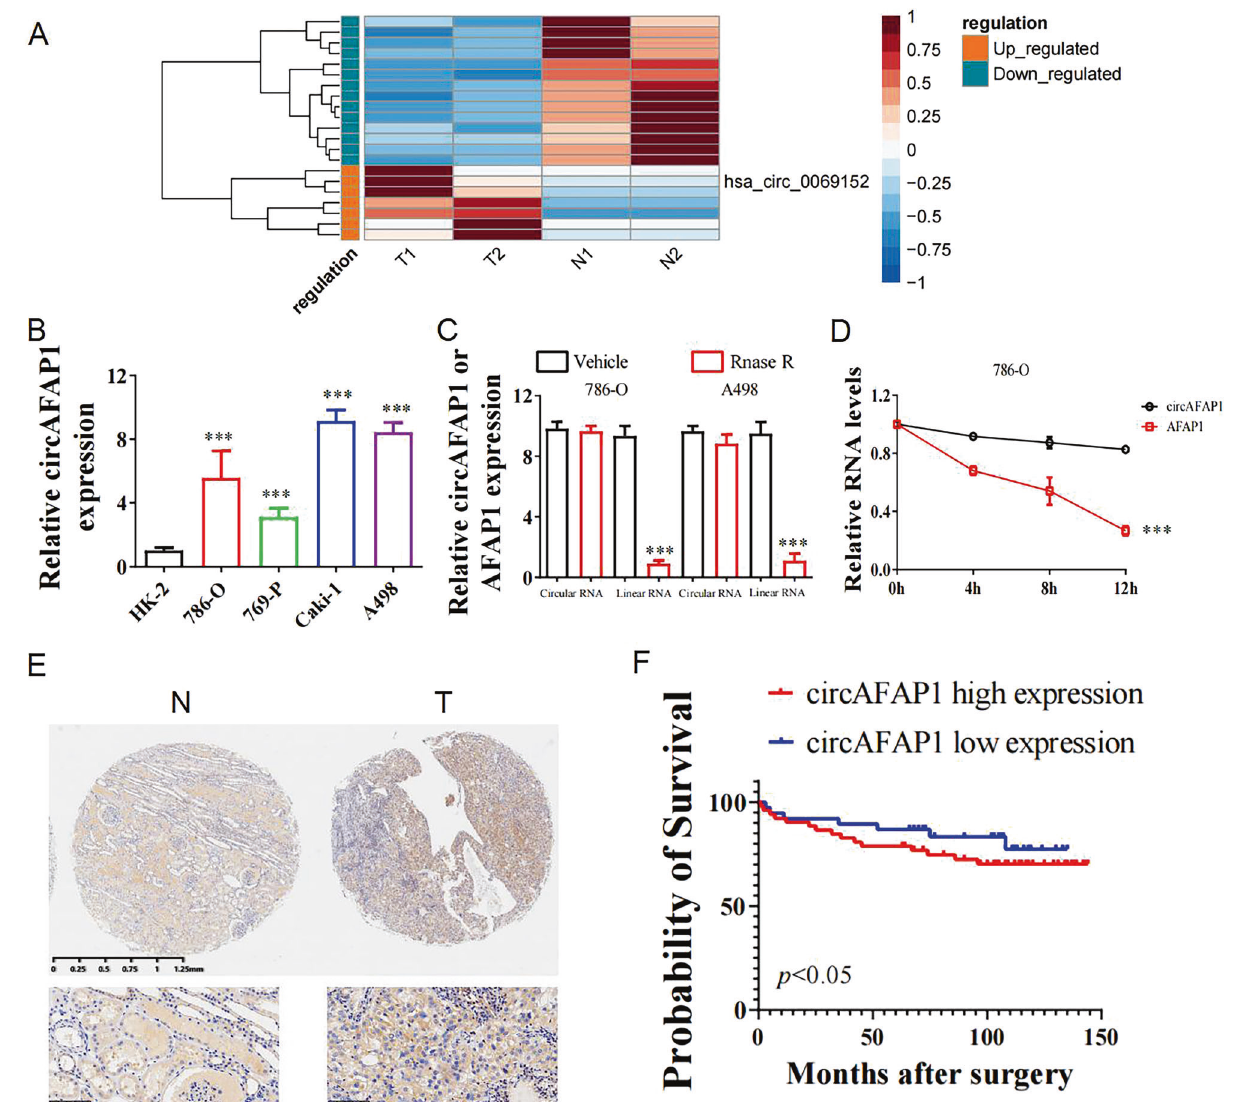
Fig. 1 circAFAP1 is upregulated in ccRCC and high expression of circAFAP1 predicted an unfavorable prognosis. A Cluster heatmap for 21 deregulated circRNAs in two paired ccRCC and pericarcinomatous tissues ( fi ltered by P < 0.05 and |FC (fold change)| ≥ 2). Columns represent tissues while rows for differentially expressed circRNAs, with circAFAP1 identi fi ed on the right of its rows. B qRT-PCR was analyzed for the expression of circAFAP1 in normal renal tubular epithelial cells line HK-2 and ccRCC cell lines 786-O, 786-P, Caki-1, and A498. Data were shown as the means ± SD. ***represents p < 0.001. C qRT-PCR was analyzed for expression of circAFAP1 and linear mRNA-AFAP1 in 786-O and A498 cells treated with or without RNase. Data were shown as the means ± SD. ***represents p < 0.001. D qRT-PCR detected the residual level of circAFAP1 and linear mRNA-AFAP1 in 786-O cells treated with Actinomycin D at the speci fi c time point. Data were shown as the means ± SD. ***represents p < 0.001. E Tissue microarray data in 82 paired ccRCC and pericarcinomatous tissues stained by immunohistochemistry revealed circAFAP1 is upregulated in ccRCC tissue (Right panel) compared to pericarcinomatous tissues (Left panel). F Survival curves of 82 ccRCC patients with high or low expression, according to the immunohistochemical staining level and using the median value as the grouping criterion. The follow-up time spans 150 months after cancer remains low. The differentially expressed circRNAs could possess the property to relate with the tumorigenesis and tumor progression of ccRCC. We highlighted the potential of circAFAP1 because of its signi fi cant upregulation in ccRCC (Fig. 1A). Next, we performed qRT-PCR to fi gure out circAFAP1 expression in different cell lines composed of tumor cells (786-O, 786-P, Caki-1, and A498) and immortalized normal renal cells (HK-2). All of these four renal carcinoma cell lines were signi fi cantly highly expressed circAFAP1 compared to normal renal tubular epithelial cells line HK-2 (Fig. 1B). As we expected, circAFAP1 showed greater resistance this discovery and whether circAFAP1 could make a difference to the ccRCC oncogenesis and progression.